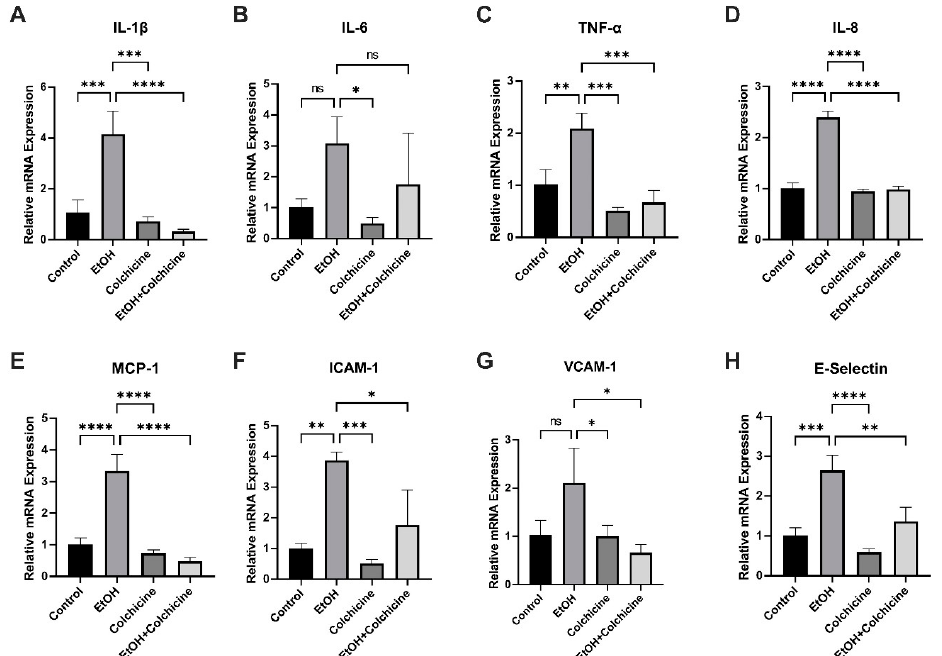
Figure 5. Colchicine attenuated the relative mRNA expression of SASP-associated inflammatory markers. Colchicine reduced the relative mRNA expression of ( A ) interleukin (IL)-1 β , ( C ) tumor necrosis factor- α (TNF- α ), ( D ) IL-8, ( E ) monocyte chemoattractant protein-1 (MCP-1), ( F ) intercellular adhesion molecule-1 (ICAM-1), and ( H ) endothelial selectin (E-Selectin) in ethanol-treated endothelial cells. Ethanol did not significantly increase the relative mRNA expression of ( B ) IL-6 or ( G ) vascular cell adhesion molecule-1 (VCAM-1). Colchicine significantly lowered the relative mRNA expression of VCAM-1 in ethanol-treated endothelial cells. β -actin was used as a loading control. qPCR data are the mean of three independent technical replicates. The data was analyzed by performing one-way ANOVA followed by Tukey’s test. Error bars represent the SD (**** p < 0.0001, *** p < 0.001, ** p < 0.01, and * p < 0.05), ns: not